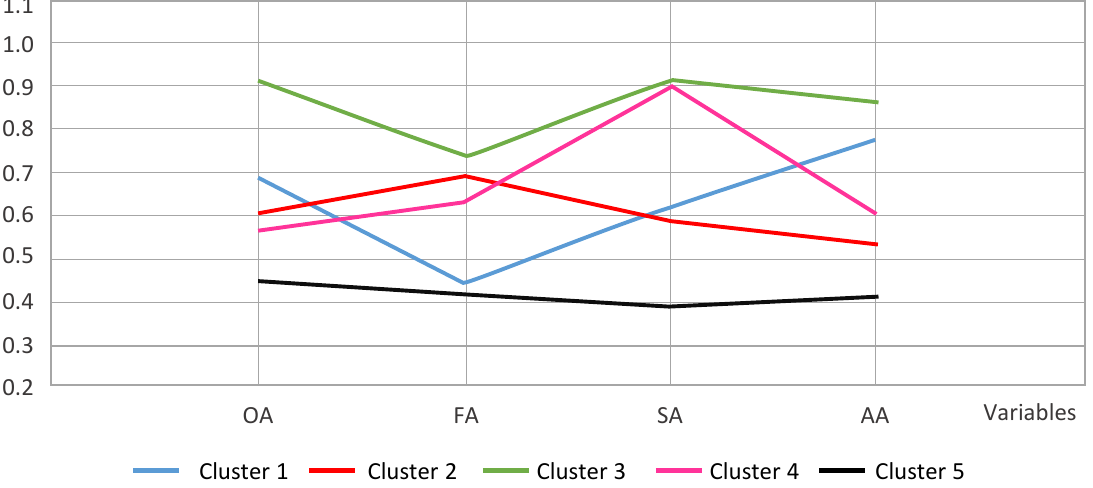
Figure 2. Division of the average values per autonomy component for five